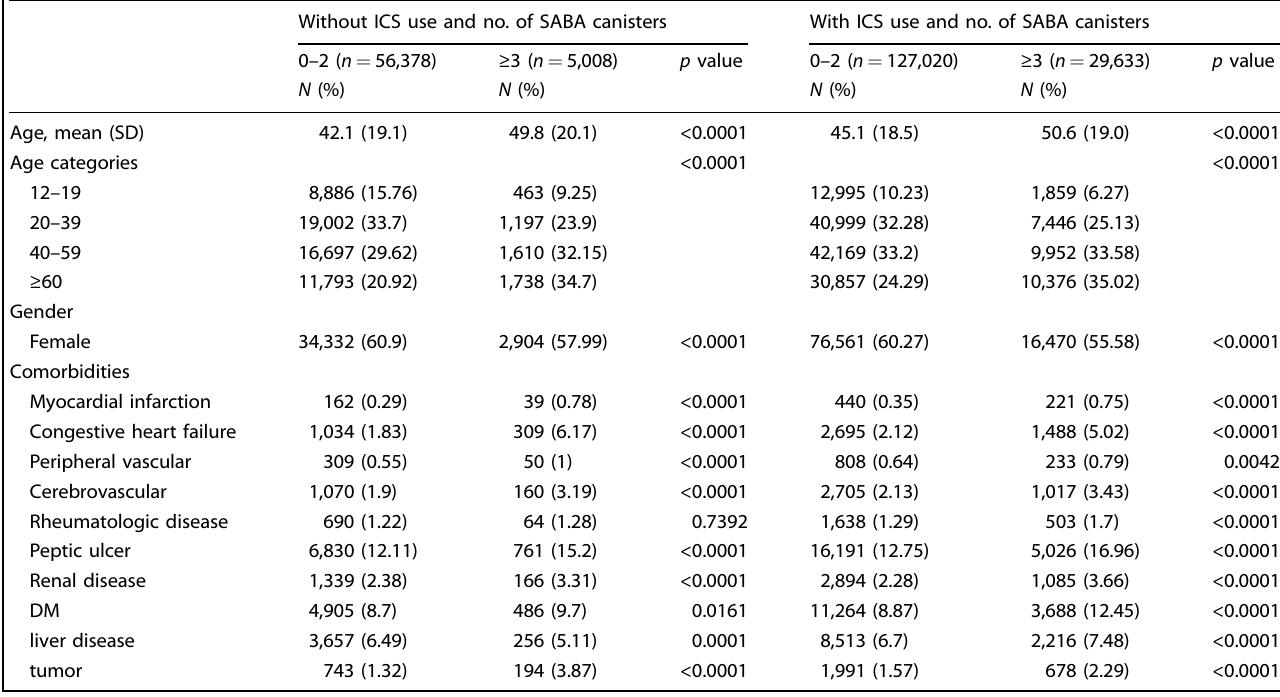
Table 1. Baseline characteristics of asthma patients on ICS therapy in different SABA use groups. Without ICS use and no. of SABA canisters With ICS use and no. of SABA canisters